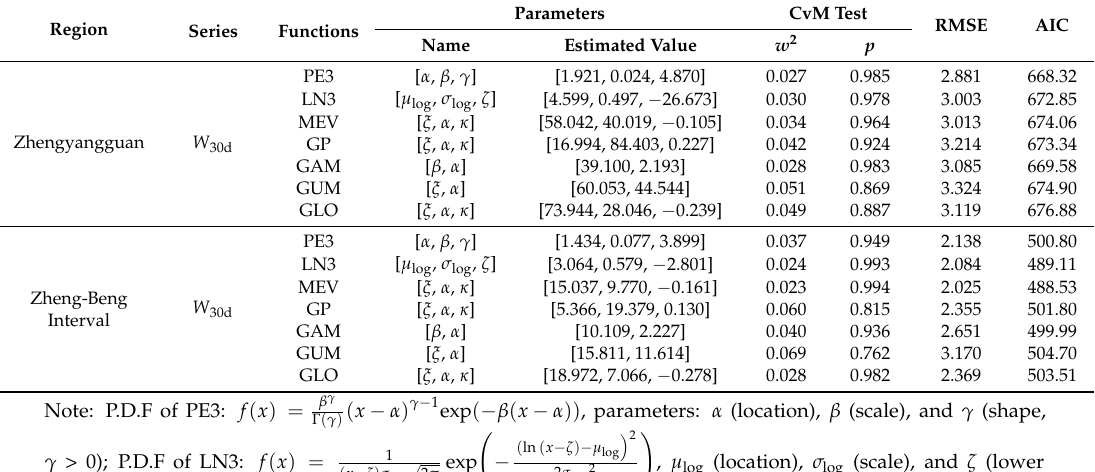
Table 3. Parameters estimated by the L-moment method and GOF of marginal distributions. Region